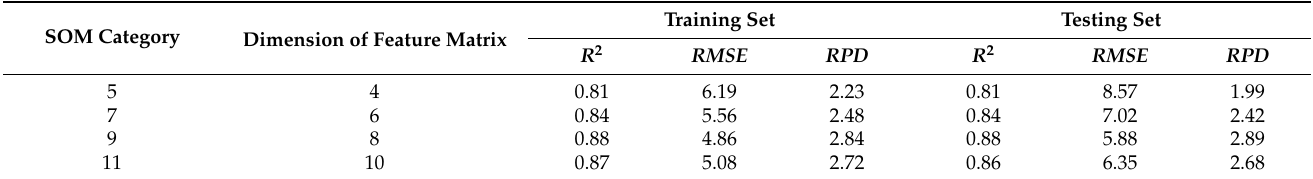
Table 6. The performance parameters for PLSR models established by LDA